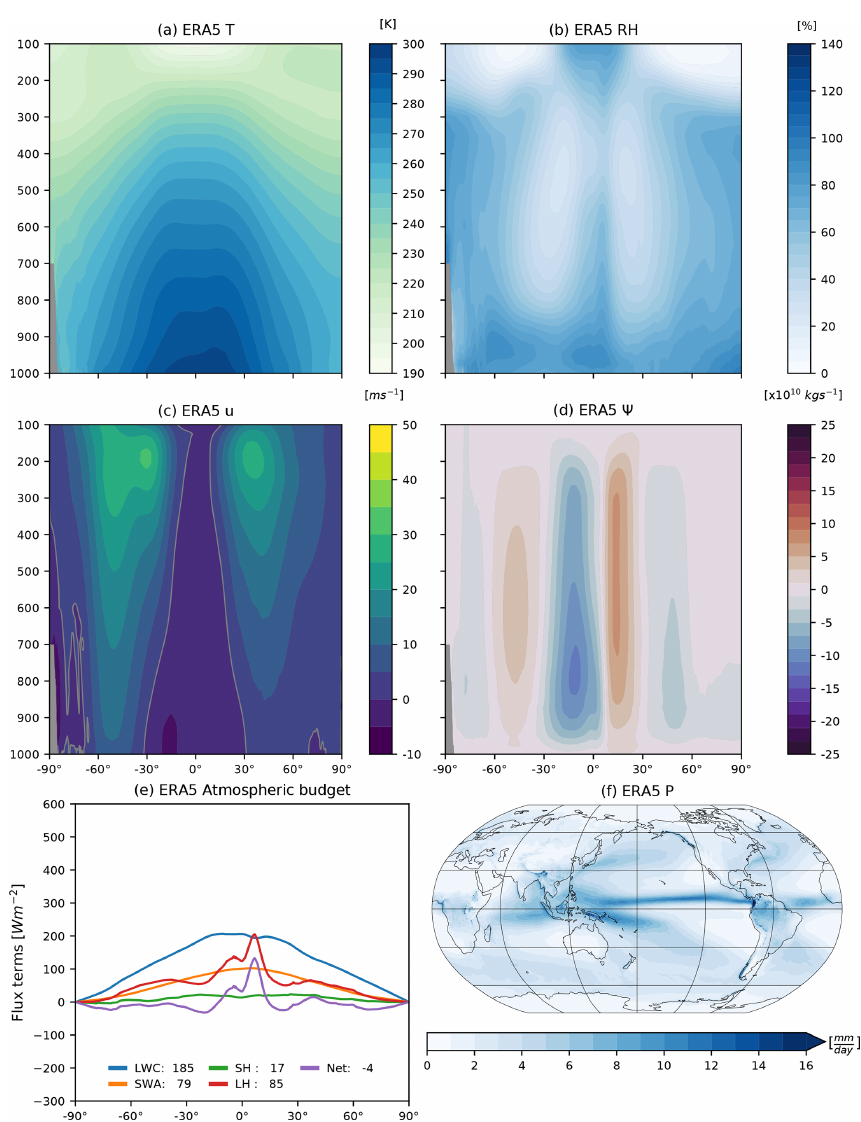
Figure 2. ERA5 reanalysis climatologies for (a) zonal-mean temperature ( T in K), (b) zonal-mean relative humidity (RH as a %), (c) zonal- mean zonal wind ( u in ms − 1 ), (d) meridional mass stream function ( ψ in × 10 10 kgs − 1 ), (e) atmospheric energy budget (see Eq. 1 in Wm − 2 ) and (f) precipitation ( P in mmd − 1 ). Grey-filled contouring in the SH in subplots in panels (a–d) indicates data masked where the surface pressure is lower than the plotted contour level. The grey line contour in the subplot in panel (c) is the zero wind contour. The legend plotted in the subplot in panel (e) indicates the area-weighted global